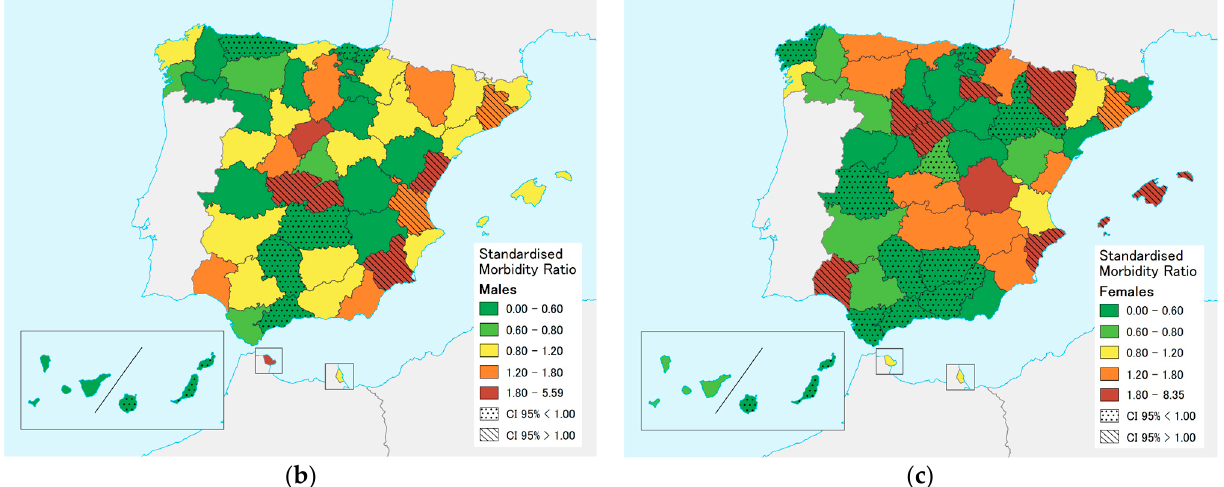
Figure 4. Geographical variability of FMF hospitalizations in Spain (2008–2015): Standardized morbidity ratios (SMRs) and 95% confidence intervals are highlighted in those cases where they were higher (striped) or lower (dotted) than expected. ( a ) Both sexes; ( b ) males; ( c ) females .